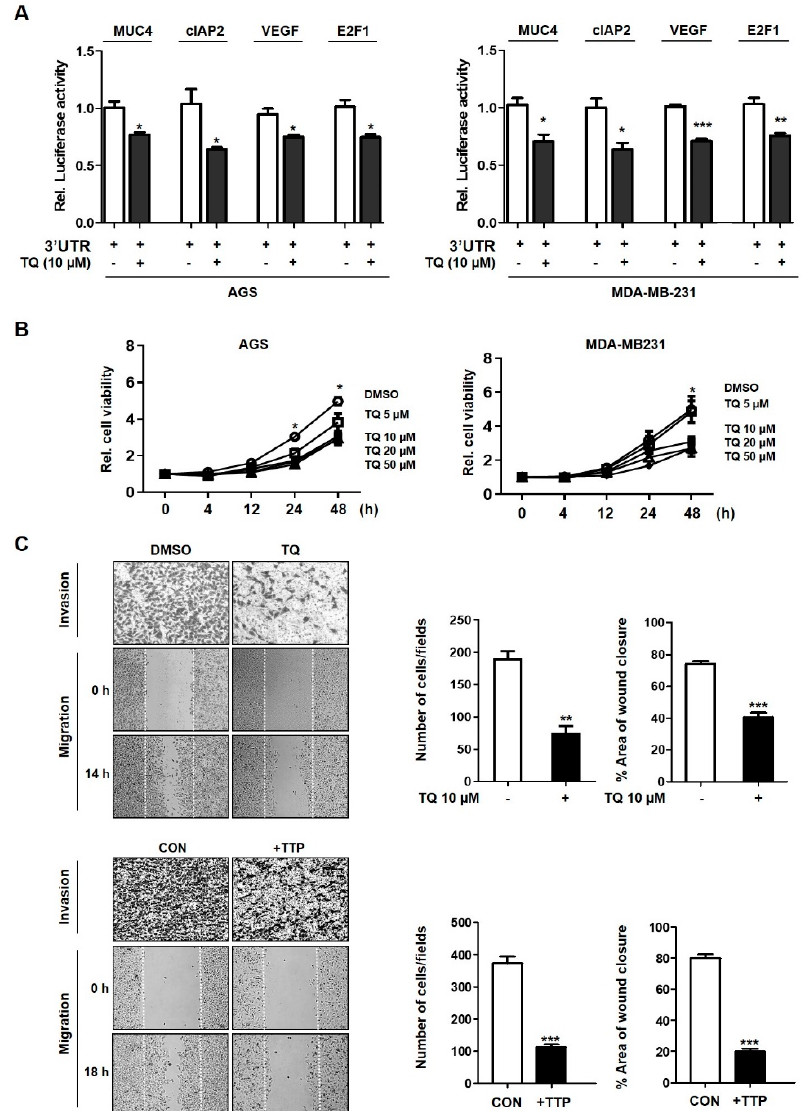
Figure 4. Induction of TTP expression by TQ inhibits tumor progression. ( A ) Cells were transfected with luciferase reporter constructs, psiCHECK2/MUC4, cIPA2, VEGF and E2F1 3 ′ UTR mRNA after treatment with TQ. The luciferase activity obtained from psiCHECK2/MUC4, cIAP2, VEGF and E2F1 3 ′ UTR transfected cells was set to 1. Each bar represents the mean ± S.D. of three independent experiments. * p < 0.05; ** p < 0.01; *** p < 0.001. ( B ) The viability of cancer cells was measured after TQ in the MTT assays. Cells treated with TQ in a dose-dependent manner were seeded at 1 × 10 4 cells per well in 96-well plates. The data represent the mean ± S.D. of three different experiments. * p < 0.05. ( C ) AGS cells treated with TQ (upper panels) and transfected TTP overexpression vector (lower panels) were examined for the rate of invasive and migratory cells. Invading cells were visualized by staining the membranes using a Diff Quick solution, and the number of cells (five fields/well) was then counted. Migrating cells was measured interval that scratched after 14 h (TQ treatment) or 18 h (TTP overexpression). The graph showed the relative percentage area of wound closure (*** p < 0.001).